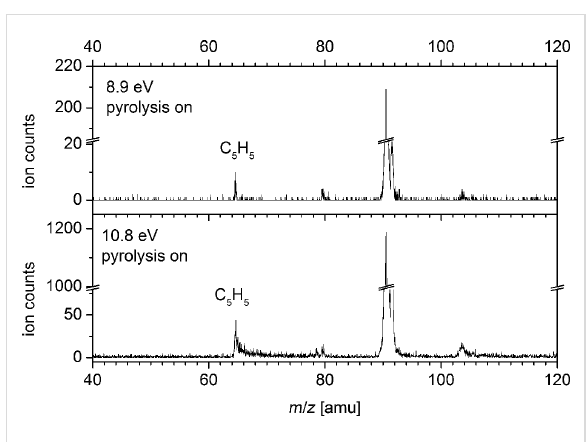
Figure 5: The shape of the C 5 H 5+ peak in the mass spectrum changes with photon energy. While the peak is symmetric at 8.9 eV, it shows a pronounced asymmetry at 10.8 eV, indicating the onset of dissociative photoionisation.